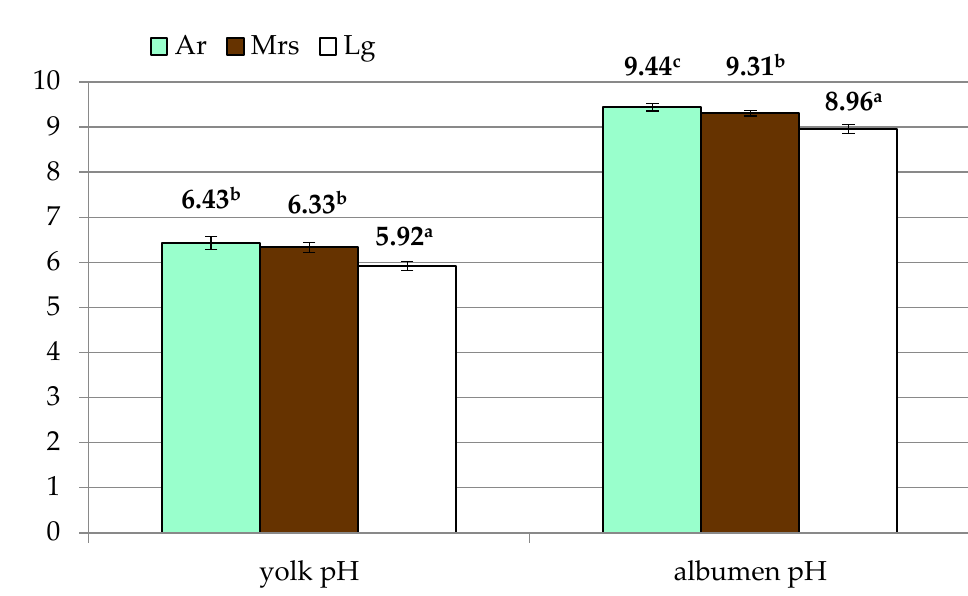
Table 3. The quality traits of the albumen of eggs from three breeds of hens differentiated by the eggshell color . Table 2. The quality traits of the yolk of eggs from three breeds of hens differentiated by the eggshell color. Trait Trait Weight (g) Haugh units